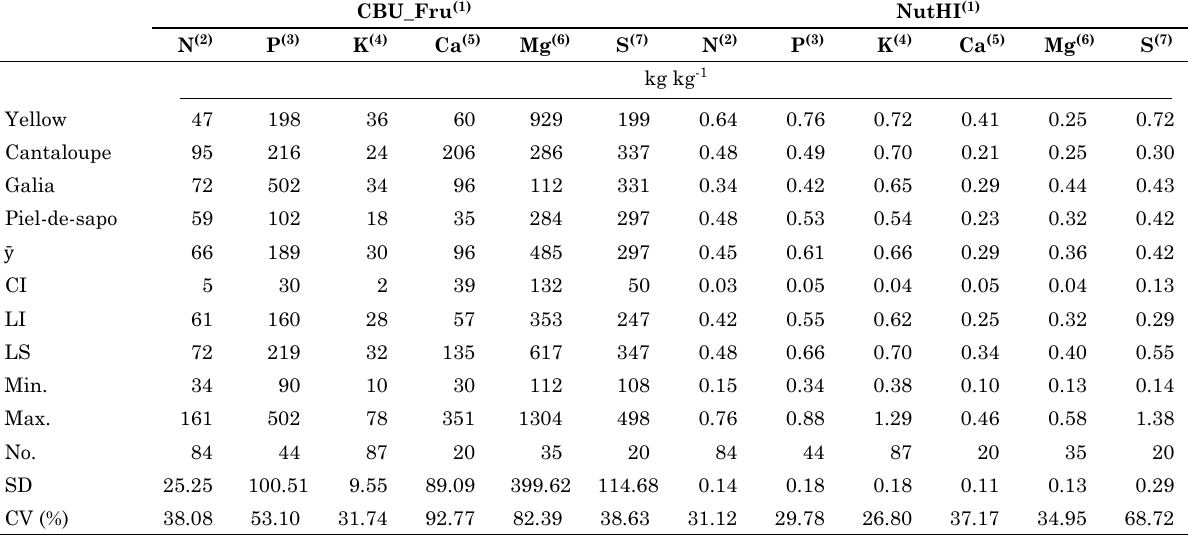
Table 1. Coefficient of biological utilization in fruit (CBU_Fru) and the nutrient harvest index (NutHI) for different melon types used in Ferticalc-melon